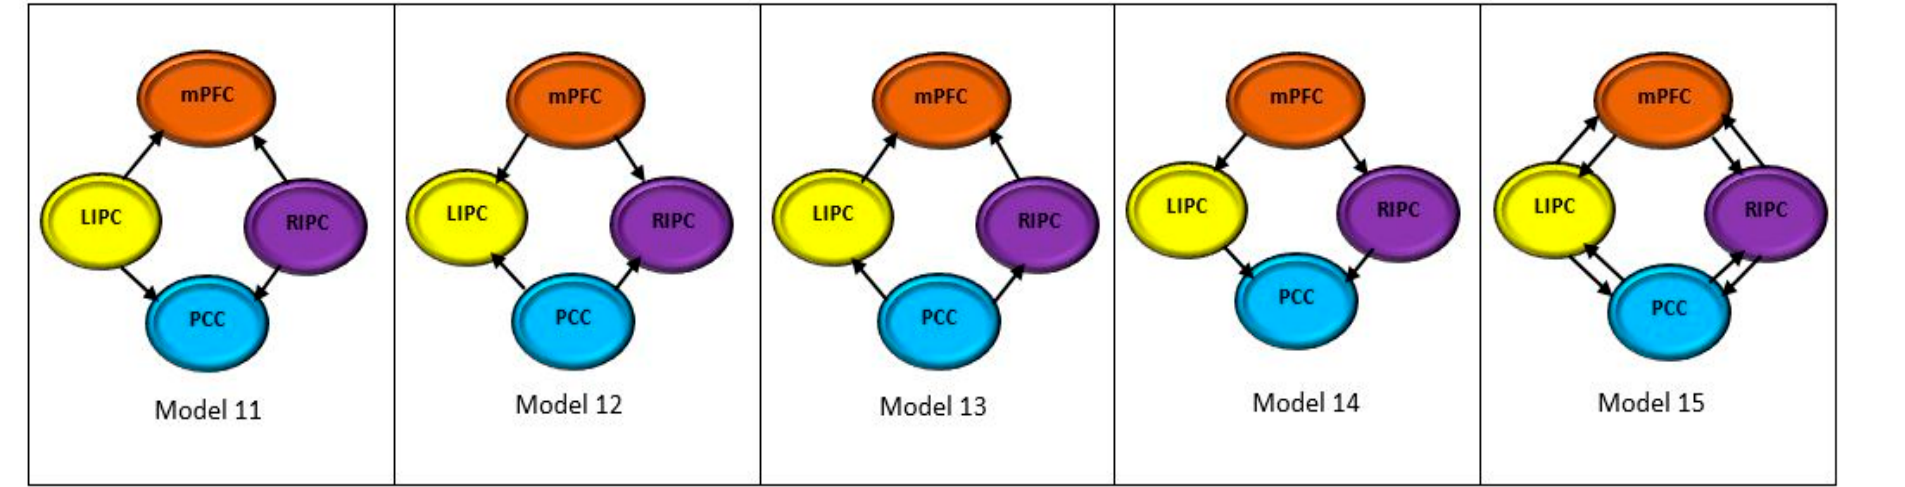
Figure 4. Causal models constructed for comparisons.